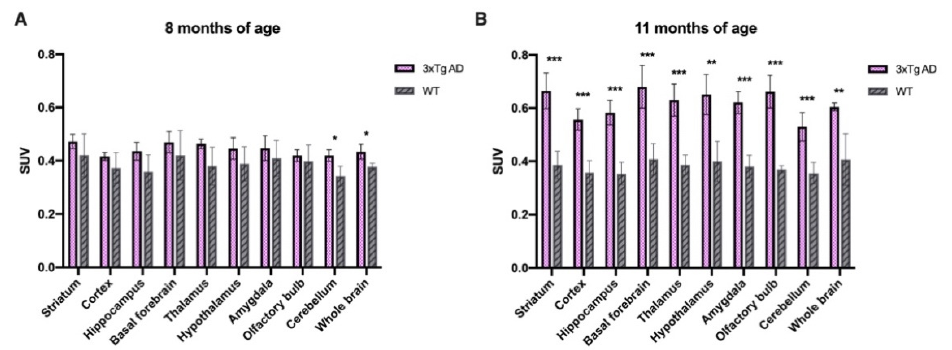
Figure 5. The uptake of [ 18 F]TFAHA was quantified and expressed in terms of standard uptake values (SUV) in different brain regions of 3xTg AD and WT mice at ( A ) 8 and ( B ) 11 months of age. Data are expressed as mean ± SD (n = 4–5/each group). The uptake in the whole brain of 3xTg AD versus WT mice was 0.433 ± 0.028 versus 0.377 ± 0.013 at 8 months of age, p = 0.011, and 0.604 ± 0.015 versus 0.371 ± 0.013 at 11 months of age, p = 0.0056 by Student’s t -test, * p < 0.05, ** p < 0.01, *** p < 0.001 by Student’s t test.